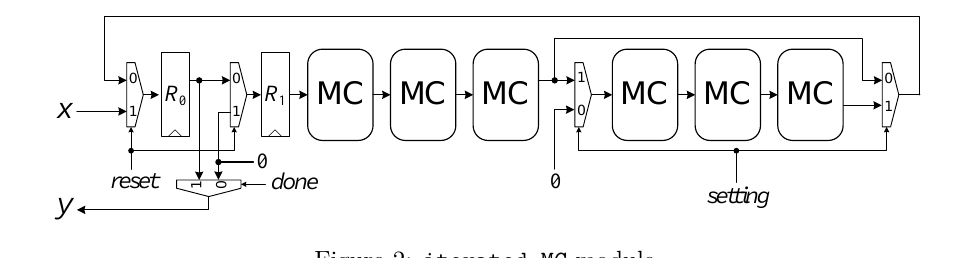
Figure 2: iterated_MC